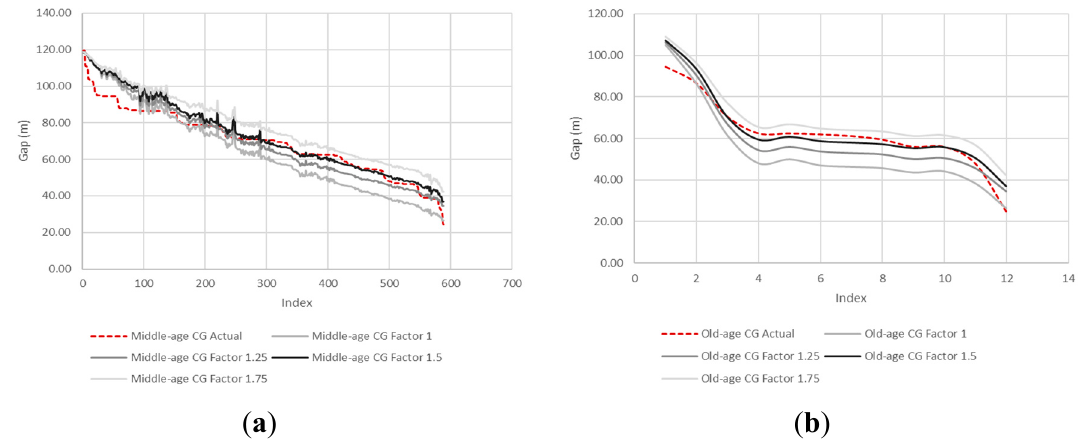
Figure 6. Comparison between actual data and simulation results per age. ( a ) Middle-age; ( b ) old-age.